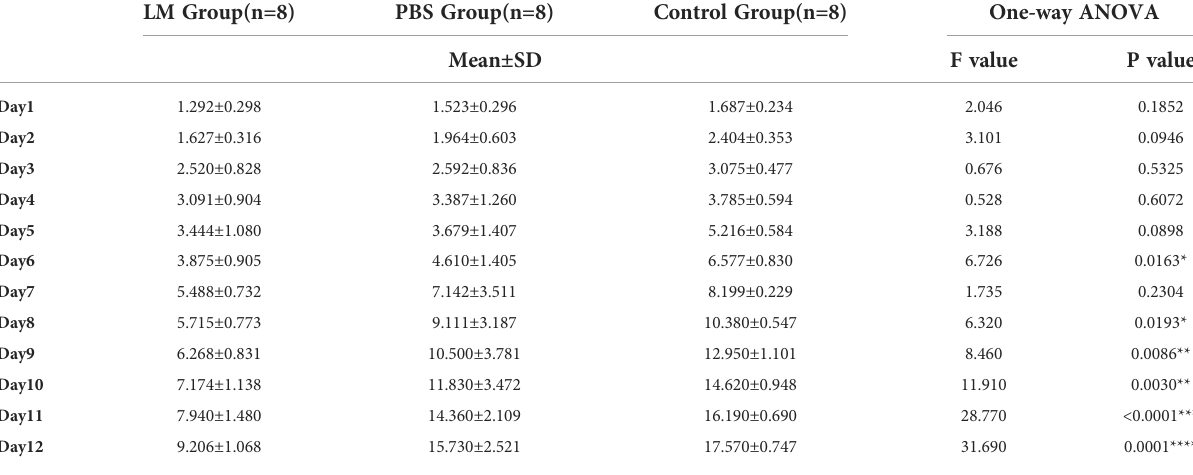
TABLE 1 The statistical results of the volumes change ratio of primary tumor across days among three groups. LM Group(n=8)